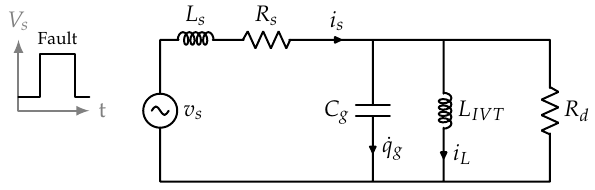
Figure 1. Per-phase equivalent circuit for parallel ferroresonance